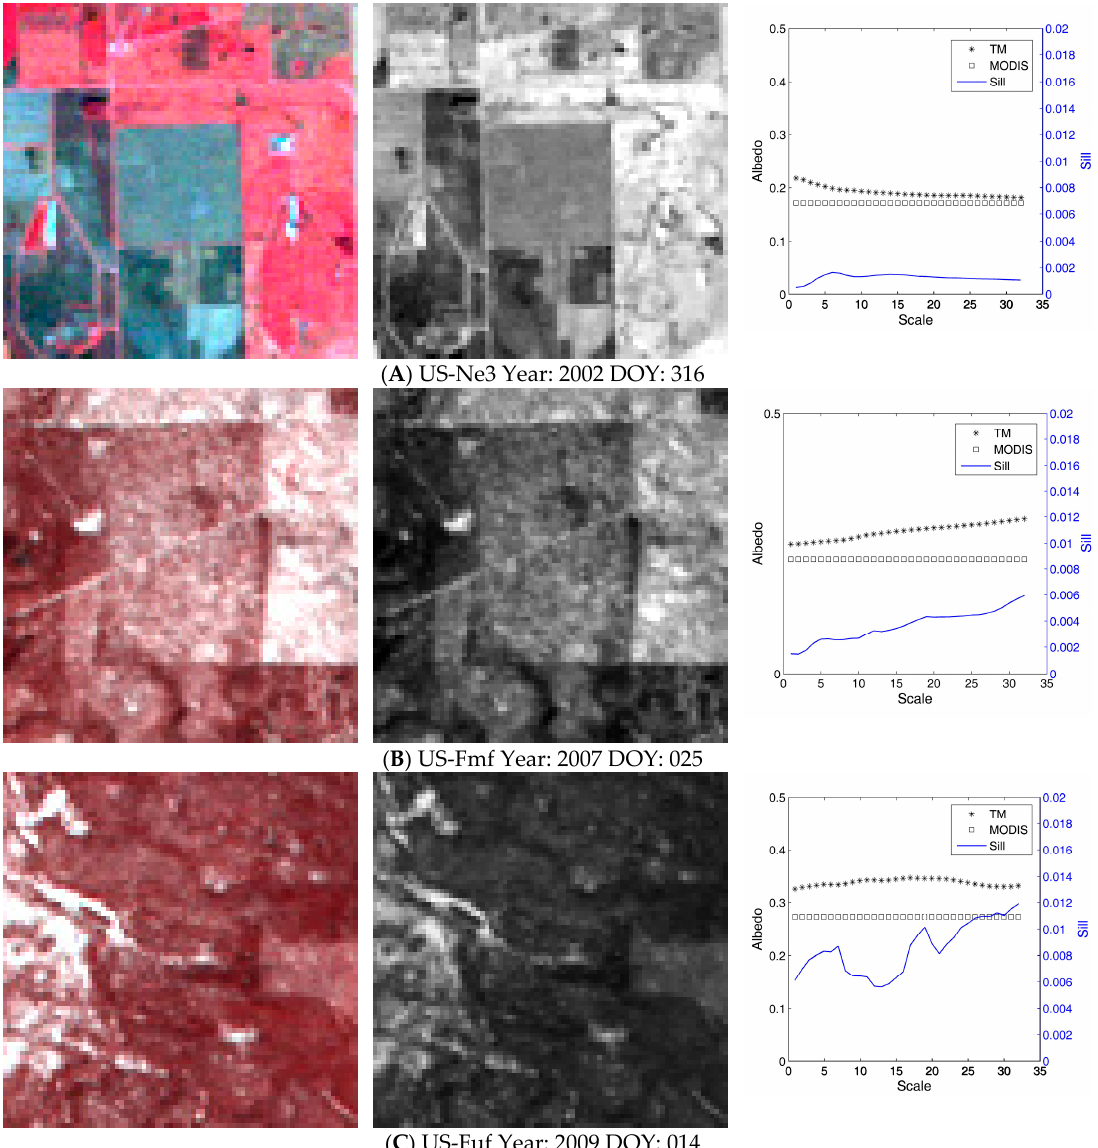
Figure 7. Three heterogeneous land surface types at ( A ) US-Ne3 cropland site, ( B ) US-Fmf evergreen needleleaf forest site and ( C ) CA-Fuf evergreen needleleaf forest site. For each site, the left figure is a false color composition of TM data, the middle figure is albedo from TM data, the right figure shows the aggregated TM albedo values at each scale, MODIS albedo, and sill value from scales 1 (15 × 15 TM pixels) to 32 (77 × 77 TM pixels) at a step of 2 TM pixels.